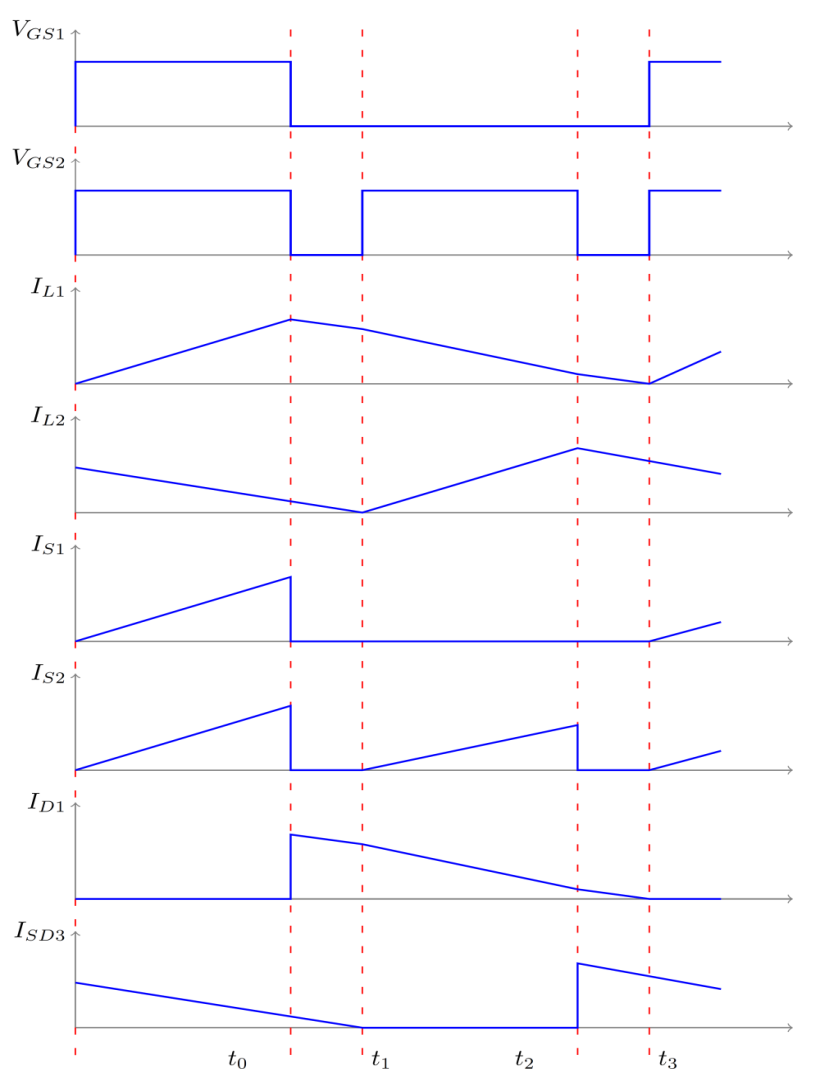
Figure 5. Mode Wave Form for ESS Charging Domain.